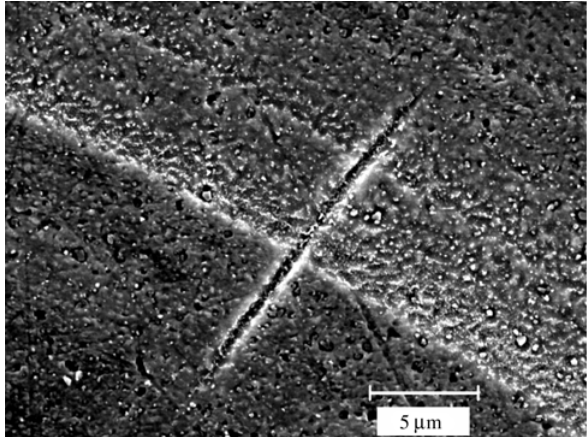
Figure 2. Scanning Electron Microscope (SEM) image of a fis- sure in a remelted